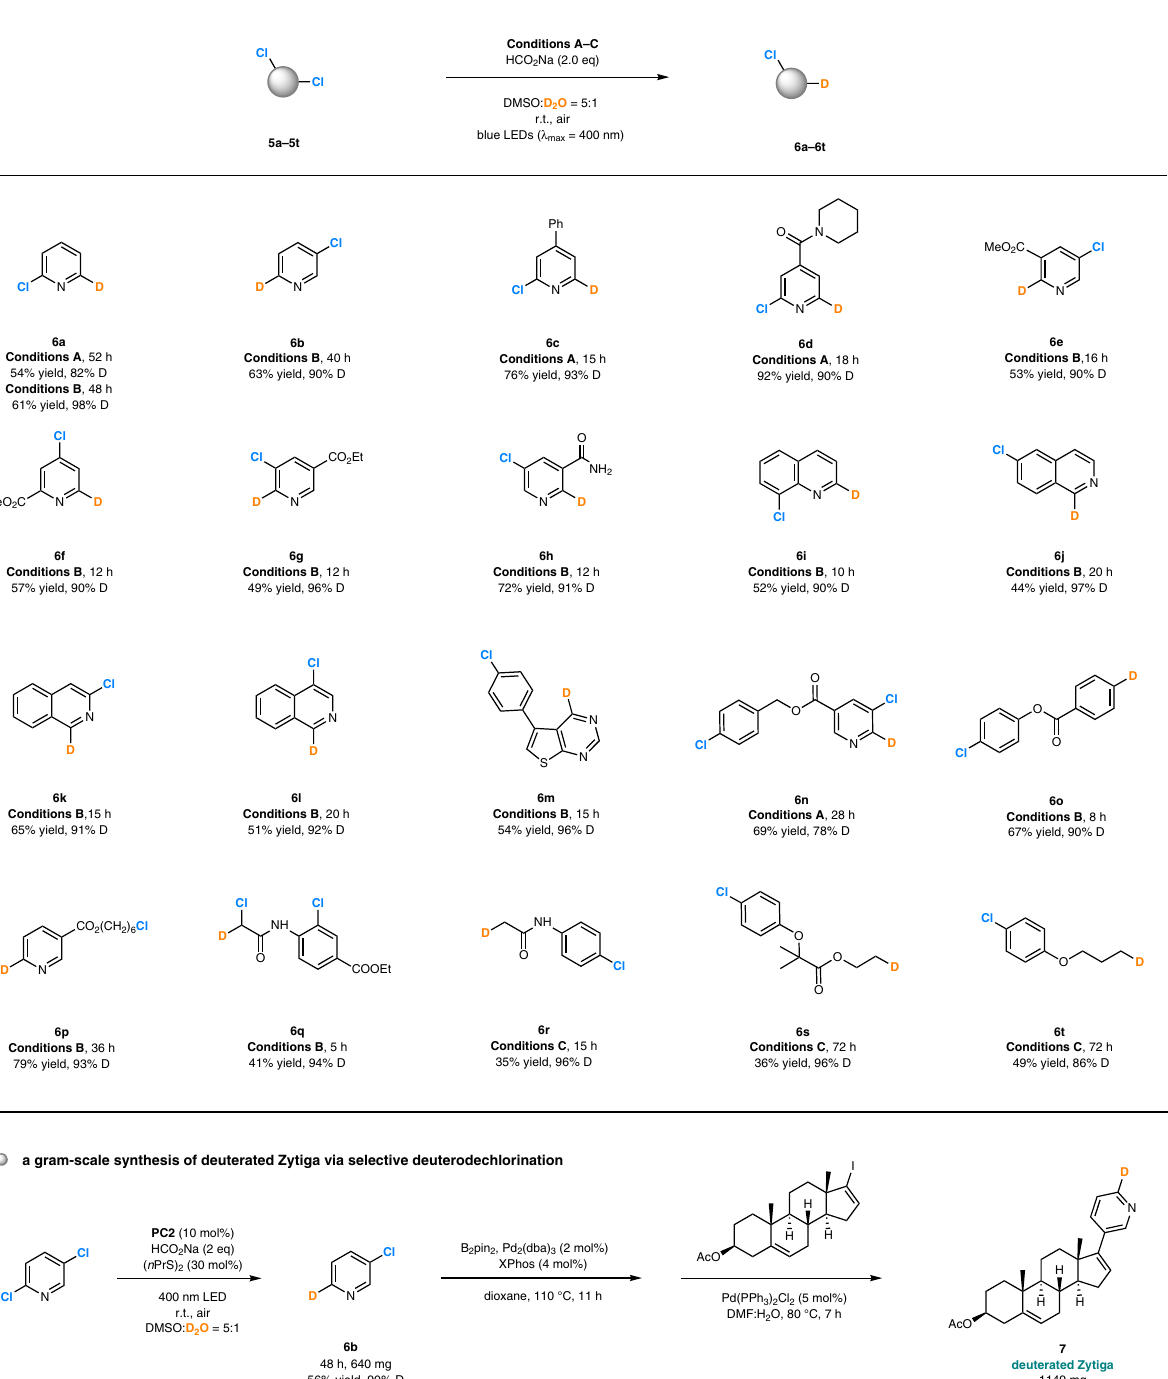
Fig. 6 Site-selective deuterodehalogenation of polychlorides. Conditions A: PC1 (10 mol%), (MeS) 2 (30 mol%). Conditions B: PC2 (10 mol%), ( n PrS) 2 (30 mol%). Conditions C: PC4 (20 mol%), ( n PrS) 2 (30 mol%). PC, photocatalyst; r.t., room temperature; eq, equivalent; DMSO, dimethyl sulfoxide; DMF, N , N -dimethylformamide; B 2 pin 2 , Bis(pinacolato)diboron.